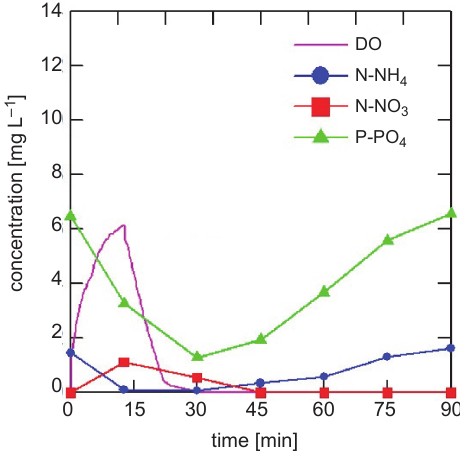
Fig. 5 – Oxygen, ammonium, nitrite, nitrate, and phosphorus concentration profiles in the IACMB. Operating cycle 15–75, t = 15 min, t = 75 min. aer mix